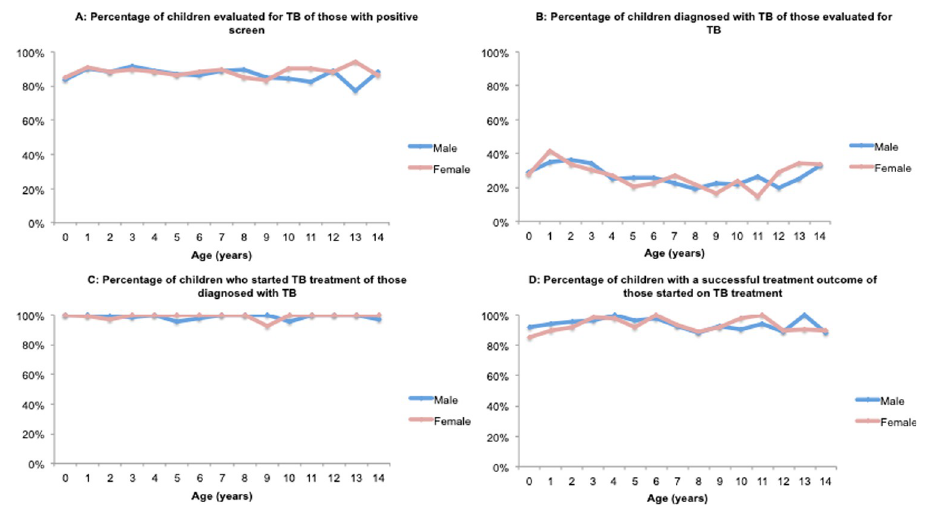
Fig 5. Percentage of children completing each step of the care cascade, by age and